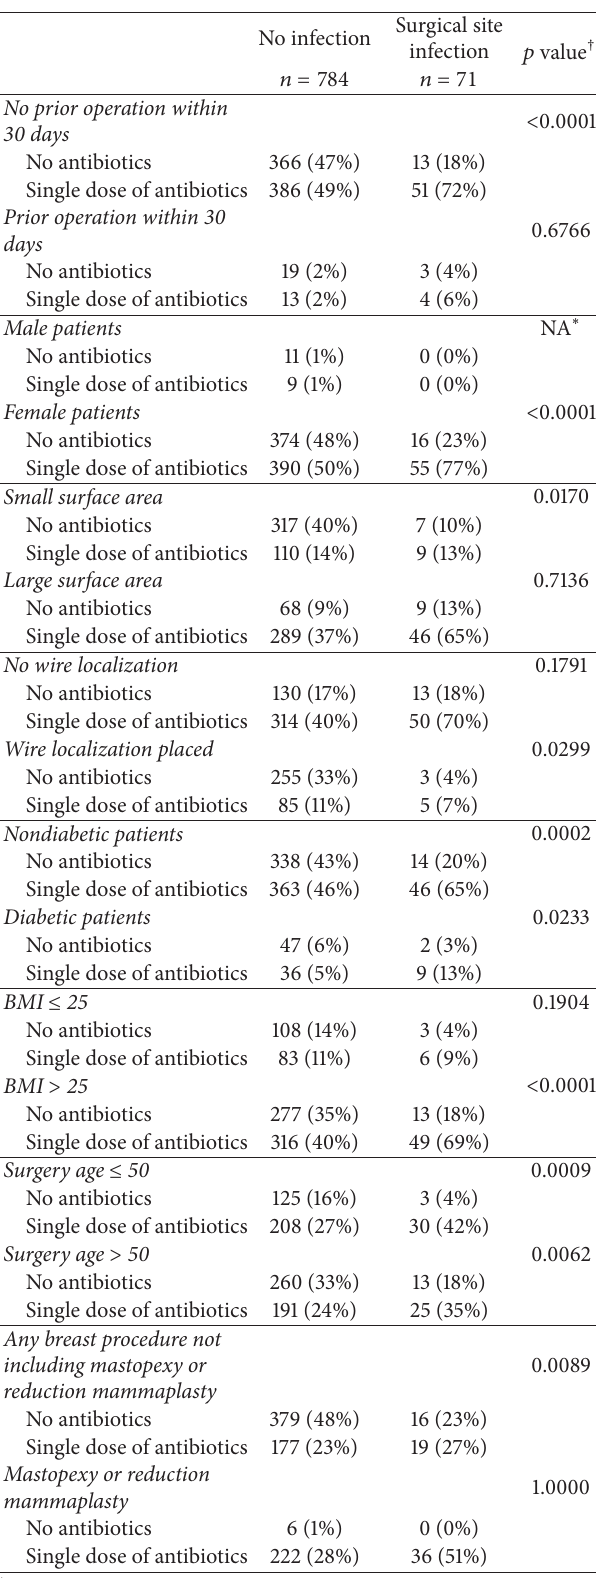
Table 3: Cross-tab analysis of clinical characteristics and antibiotic use in relation to SSI rate.